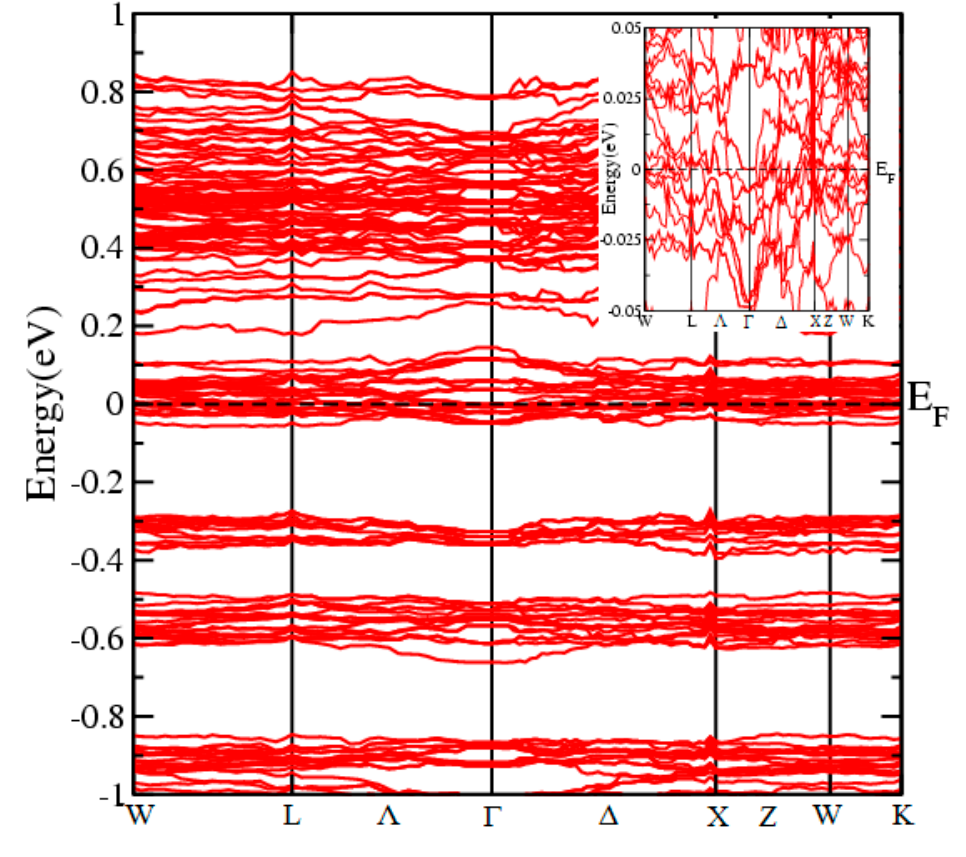
Figure 4. Electronic band structure of the HKUST-1.